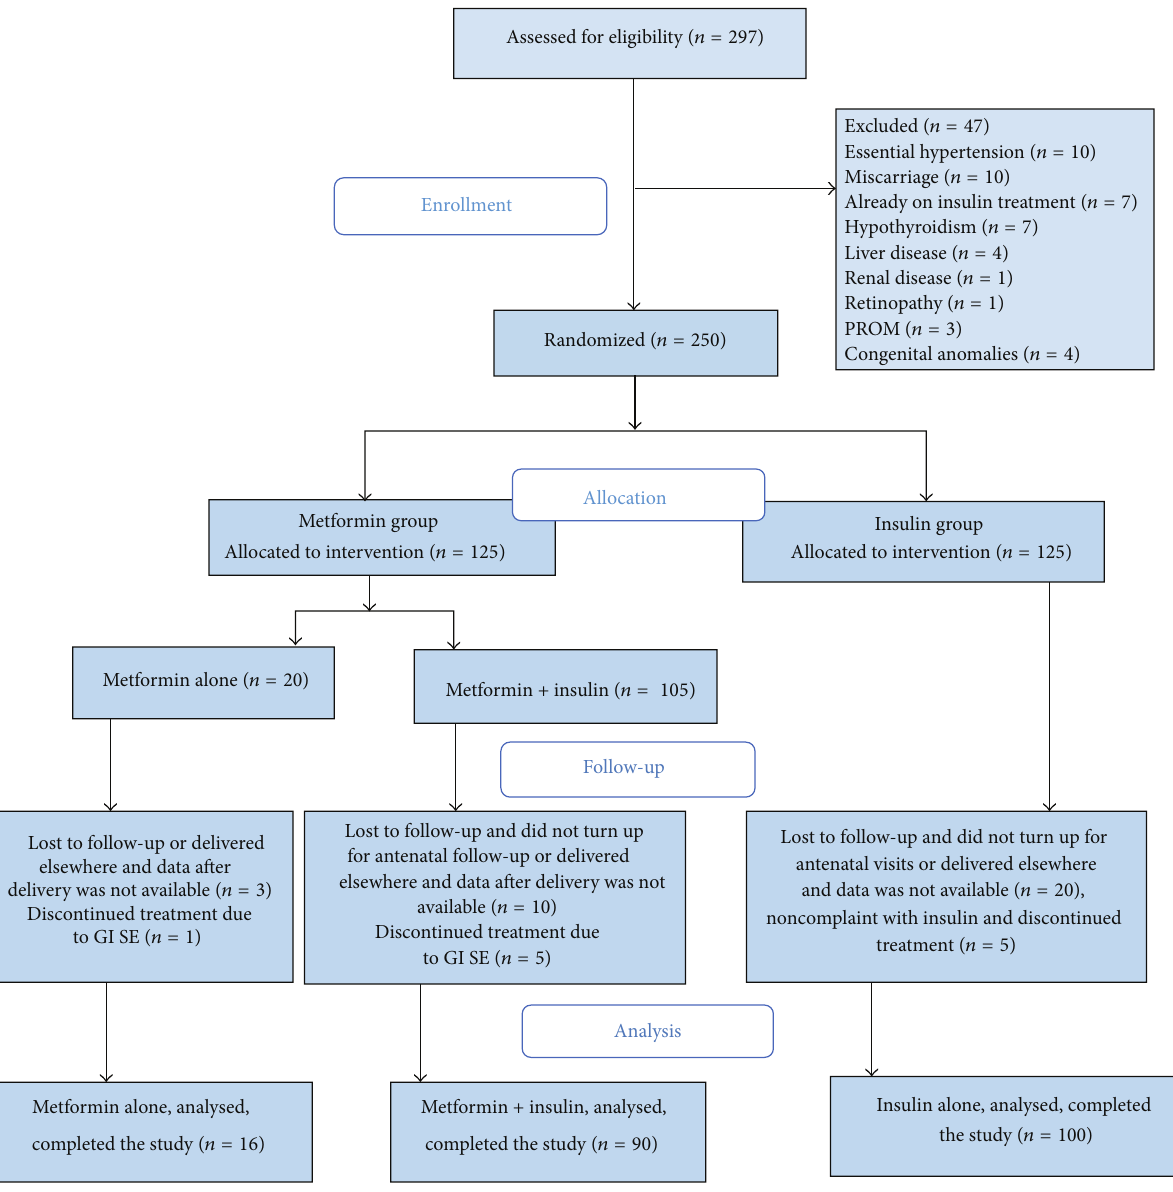
Figure 1: Flow diagram of study